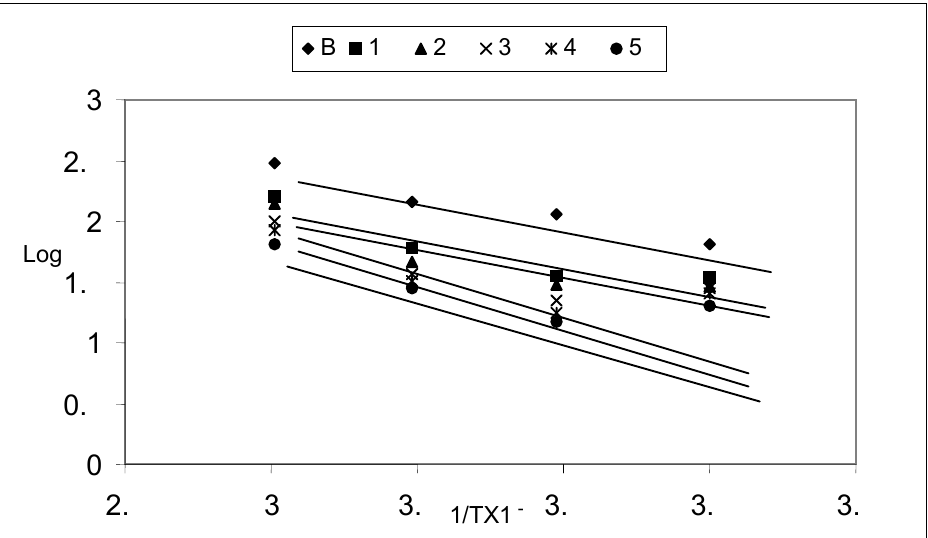
Figure 1. Arrhenius Plot for Corrosion in 2N Sulphuric acid with Morpholine.